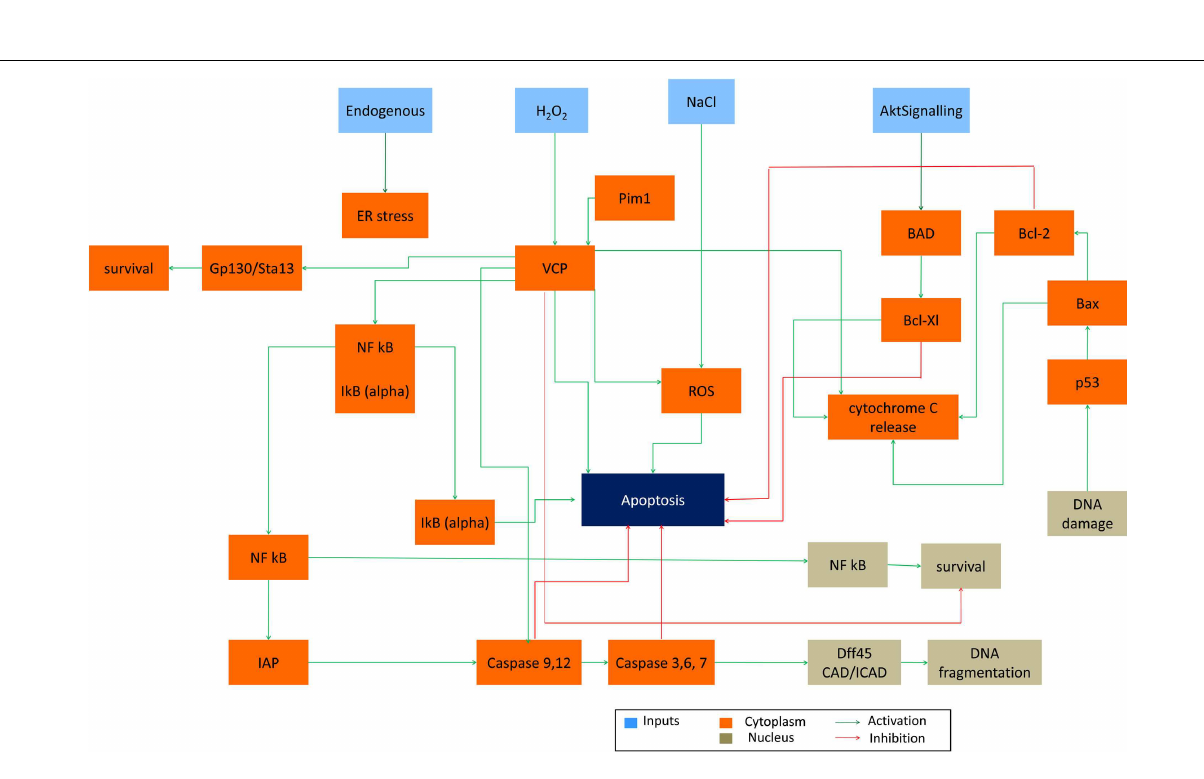
FIGURE 7 | In silico “humanized yeast apoptosis network”. Human apoptotic pathways BCL-2 protein family andVCP dependent genes inserted into the yeast apoptosis network (due to simplicity we show only human pathways).